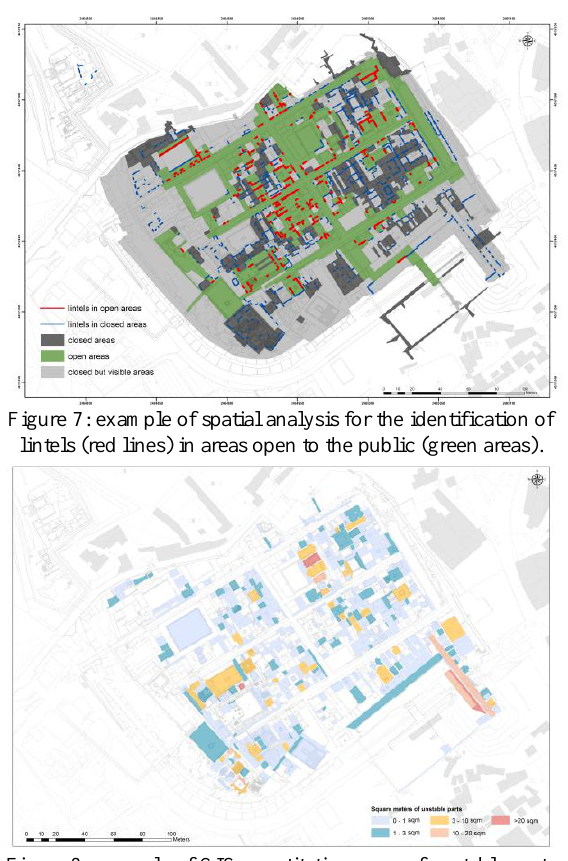
Figure 8: example of GIS quantitative maps of unstable parts of decorative features, used to design and quantify future